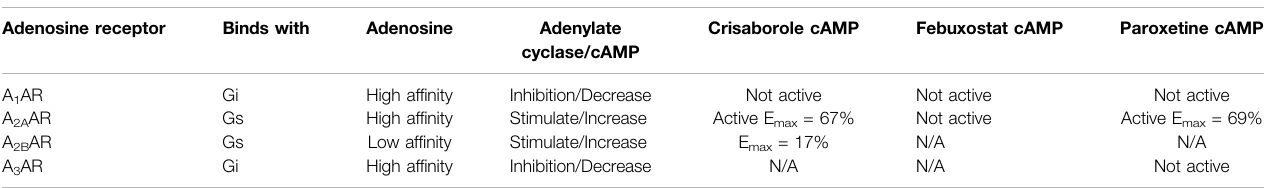
TABLE 2 | Summary table of in vitro data for compounds tested against adenosine receptors. Adenosine receptor Binds